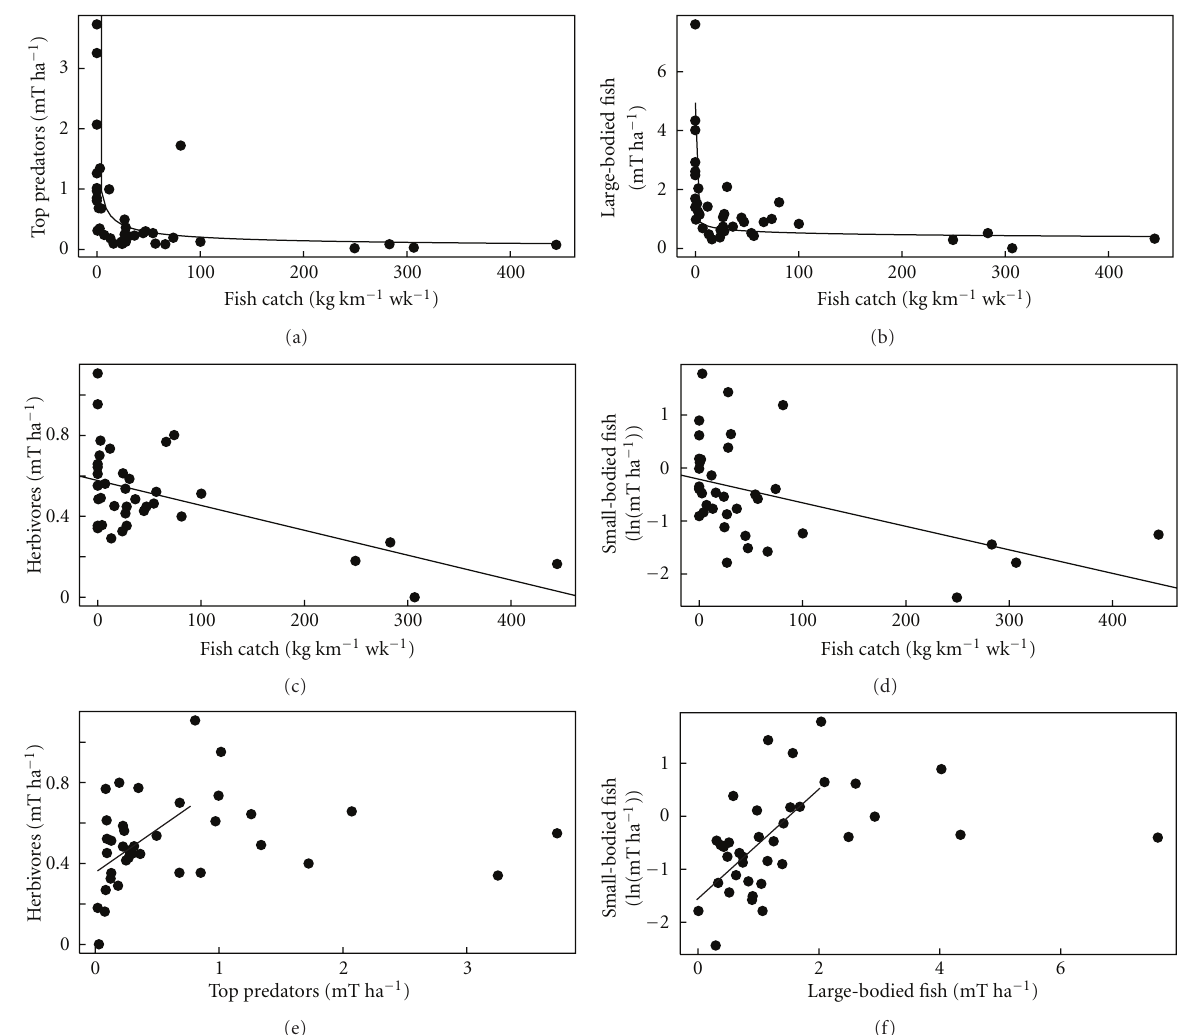
Figure 3: The e ff ects of fishing on top predators, herbivores, large- and small-bodied fish biomass. Fishing resulted in exponential declines in top predator ((a) R 2 = 0 . 58, P < . 0001; permutation test: P < . 0001) and large-bodied fishes ((b) R 2 = 0 . 43, P < . 0001, permutation test: P < . 0001) biomass. Herbivores ((c) R 2 = 0 . 30, P < . 001, permutation test: P < . 0001) and small-bodied fishes ((d) R 2 = 0 . 22, P < . 01, permutation test: P < . 01) biomass declined linearly with fish catch. Herbivore biomass only declined when top predator biomass was less than 0.81mT/ha (95% CI: 0.16, 1.44) ((e) R 2 = 0 . 24, P < . 01, permutation test: P < . 05). Small-bodied fish biomass only declined